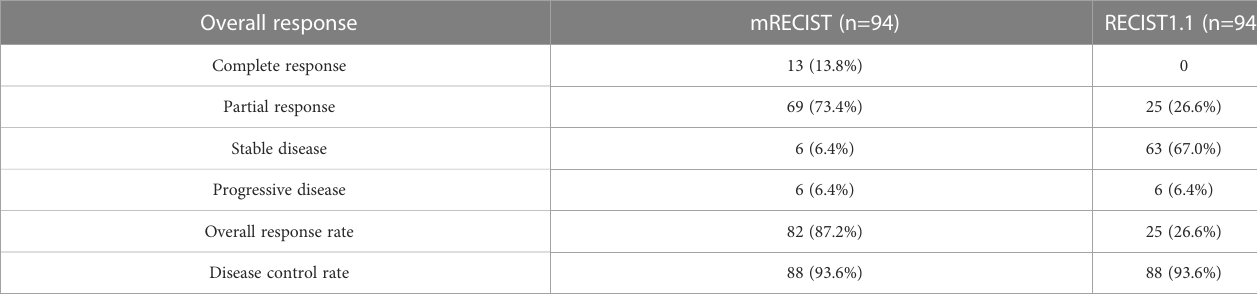
TABLE 2 Treatment response to conversion therapy based on mRECIST and